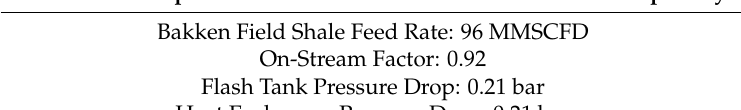
Table 1. General process assumptions. General Assumptions. MMSCFD: million standard cubic feet per